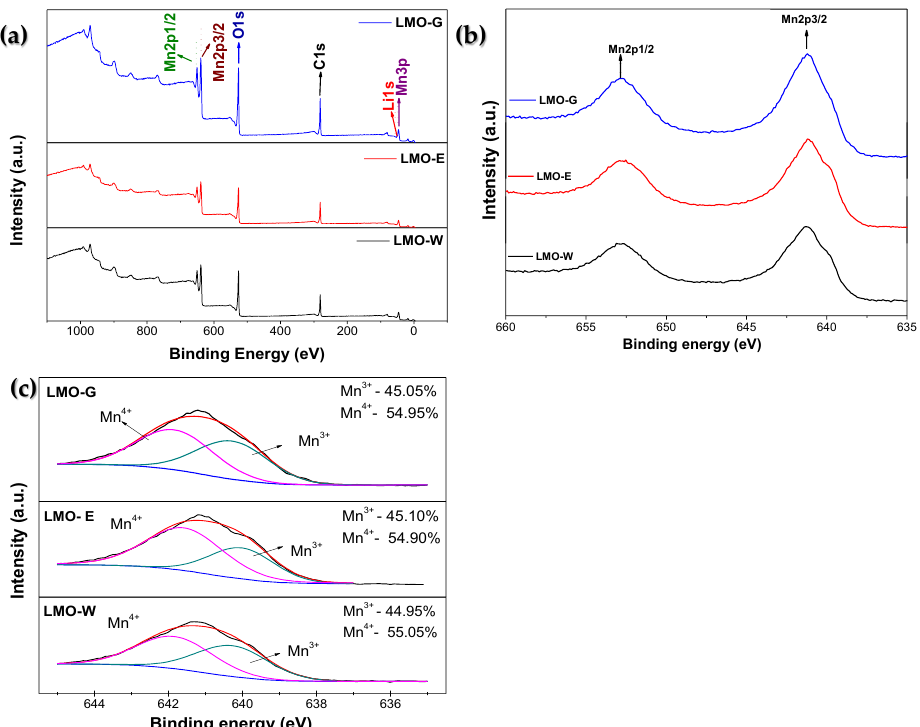
Figure 5. XPS spectra for LMO samples: ( a ) full spectra; ( b ) Mn 2p peaks of LMO samples; ( c ) deconvoluted profiles of Mn 2p 3/2 XPS spectra.